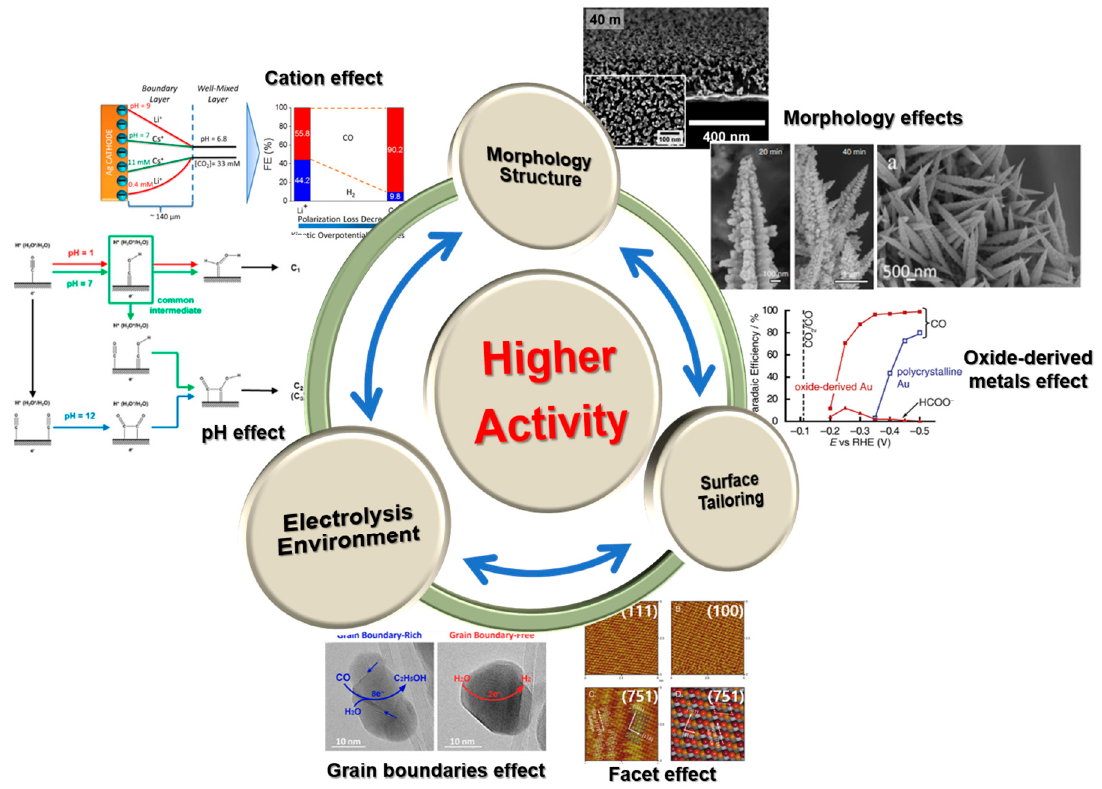
Figure 5. Schematic of a typical home-made electrochemical reactor for liquid-phase CO 2 reduction. A liquid-phase reactor consists of two chambers for the anode and cathode, a membrane, and so on. The volume and area depend on the purpose of the user. Reprinted with permission from the authors of [96].